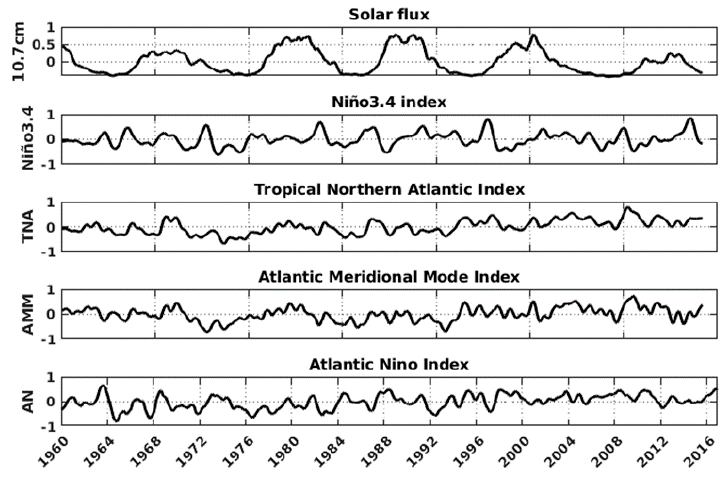
Figure 3. Temporal evolution of normalized climate indices: Sun Spot Number, El Niño 3.4, Tropical Northern Atlantic, Atlantic Meridional Mode and Atlantic Niño, from 1960 to 2016. The variation of Atlantic SST influences some climate parameters in the surrounding